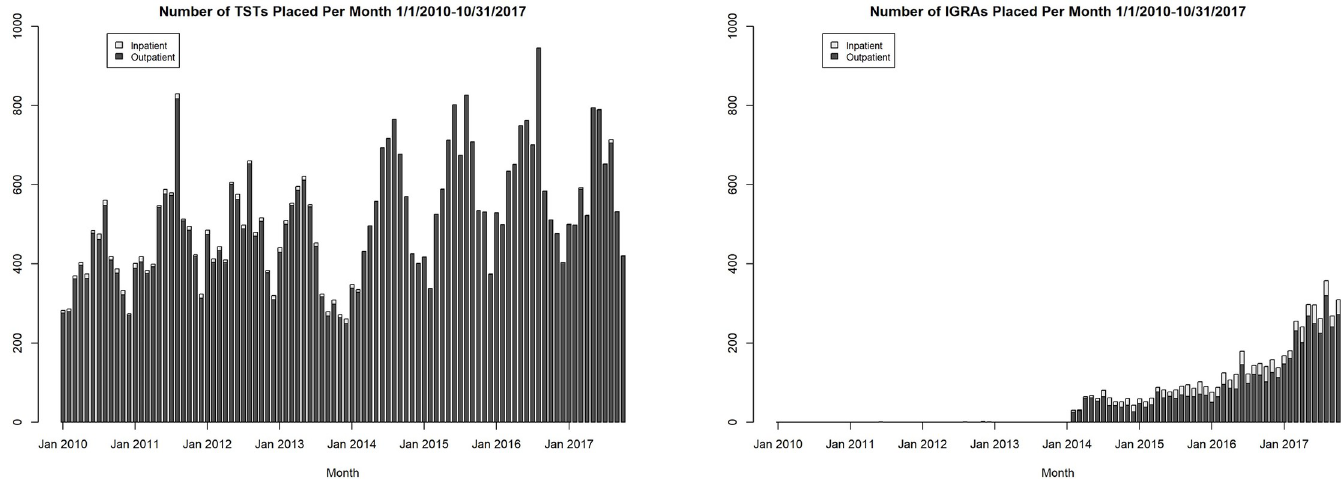
Fig 1. Number of TSTs and IGRAs placed per month in the Duke University Health System, January 1, 2010 to October 31, 2017.